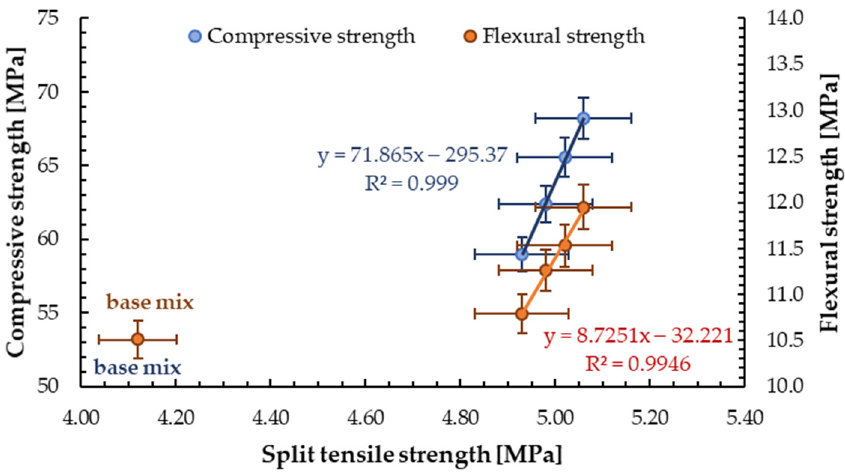
Figure 14. The ratio of tensile strength to compressive strength for samples with GSA.